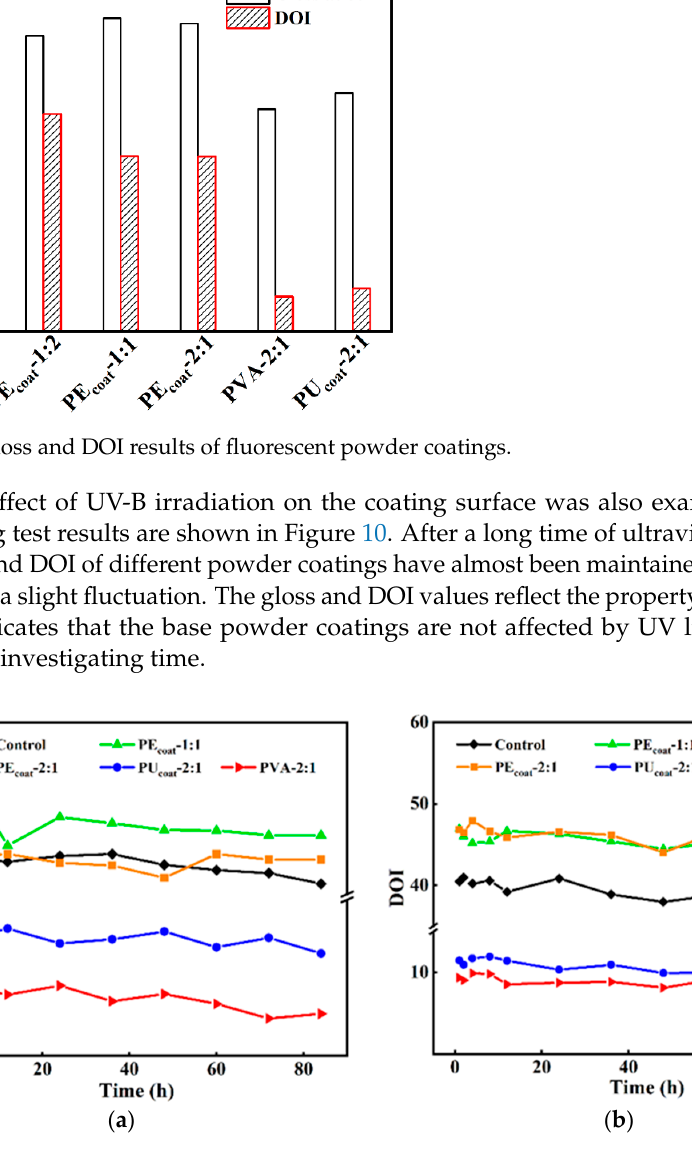
Figure 10. Gloss and DOI results of fluorescent powder coatings: ( a ) gloss; ( b )